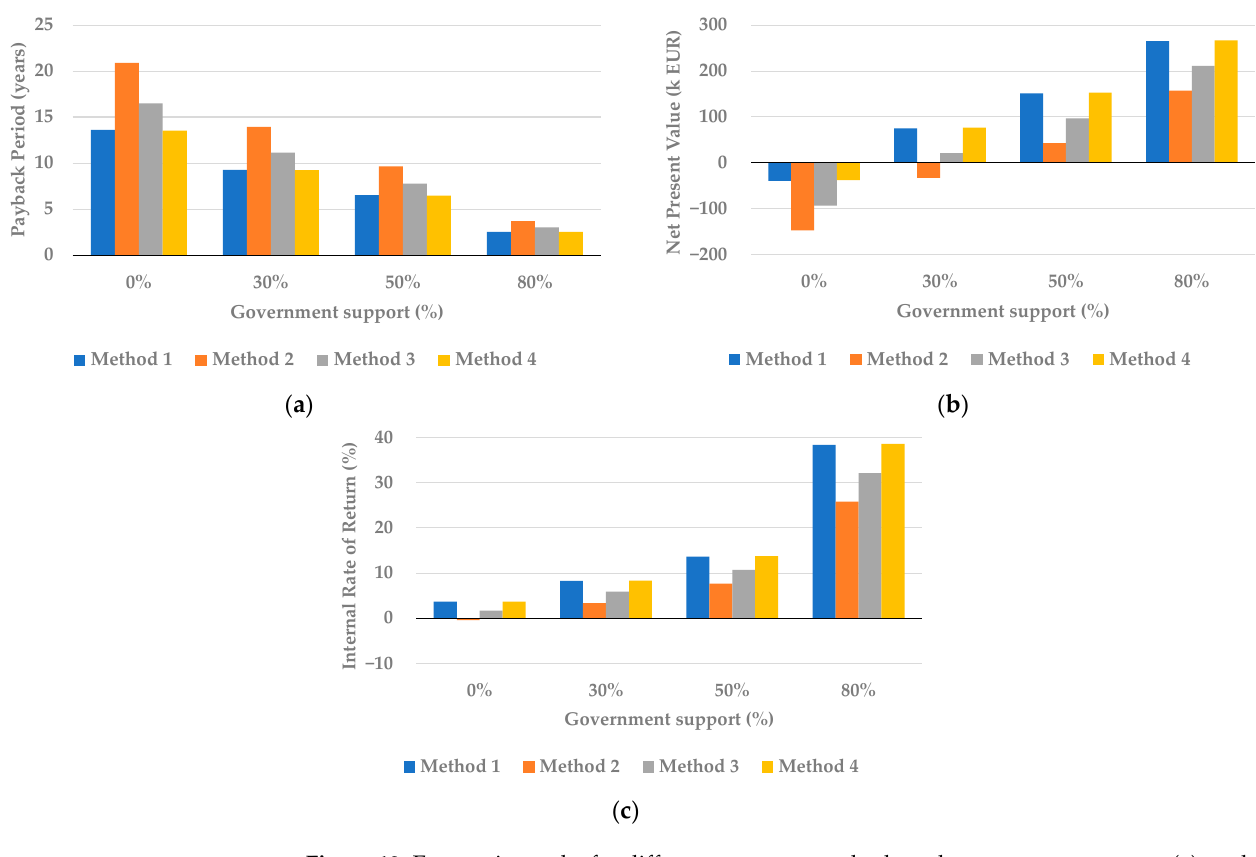
Figure 10. Economic results for different payment methods and government support: ( a ) payback period; ( b ) net present value; ( c ) internal rate of